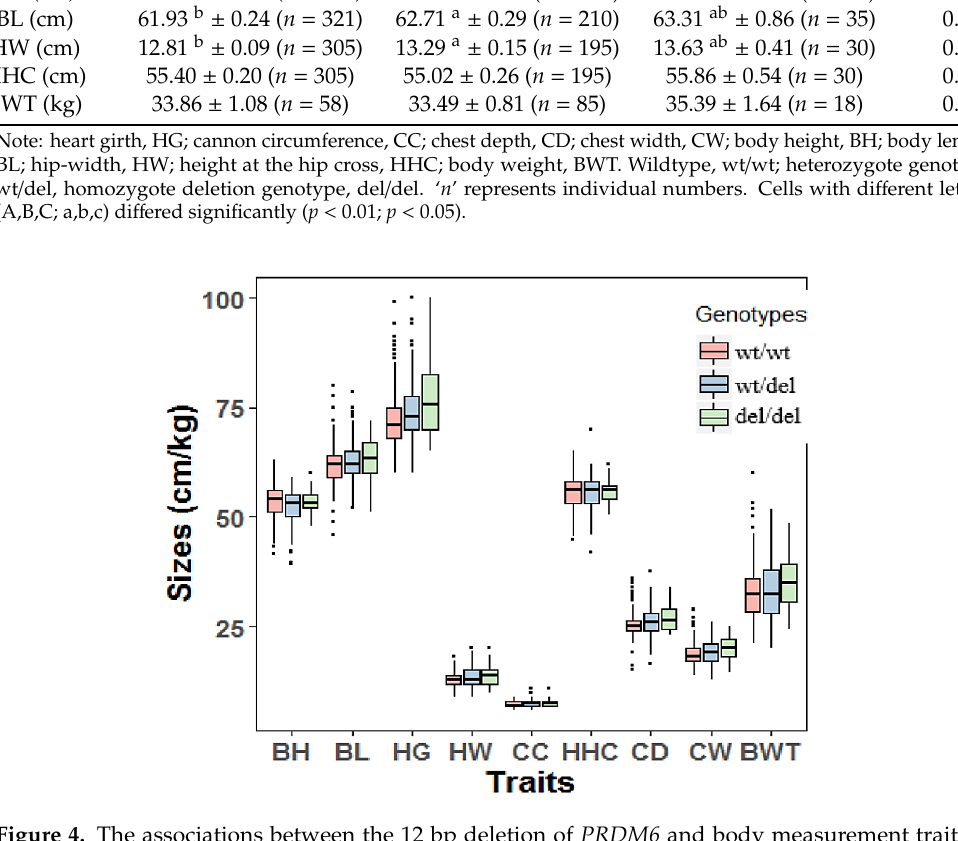
Figure 4. The associations between the 12 bp deletion of PRDM6 and body measurement traits of yearling Shaanbei cashmere goats. Wildtype, wt / wt; heterozygote genotype, wt / del, homozygote deletion genotype, del / del. Body height (cm), BH; body length (cm), BL; heart girth (cm), HG; hip-width (cm), HW; cannon circumference (cm), CC; height at hip cross (cm), HHC; chest depth (cm), CD; chest width (cm), CW; body weight (kg), BWT. Table 5. E ff ects of PRDM6 gene deletion mutations and growth traits of Shaanbei white cashmere goats in the adult period (mean ± standard